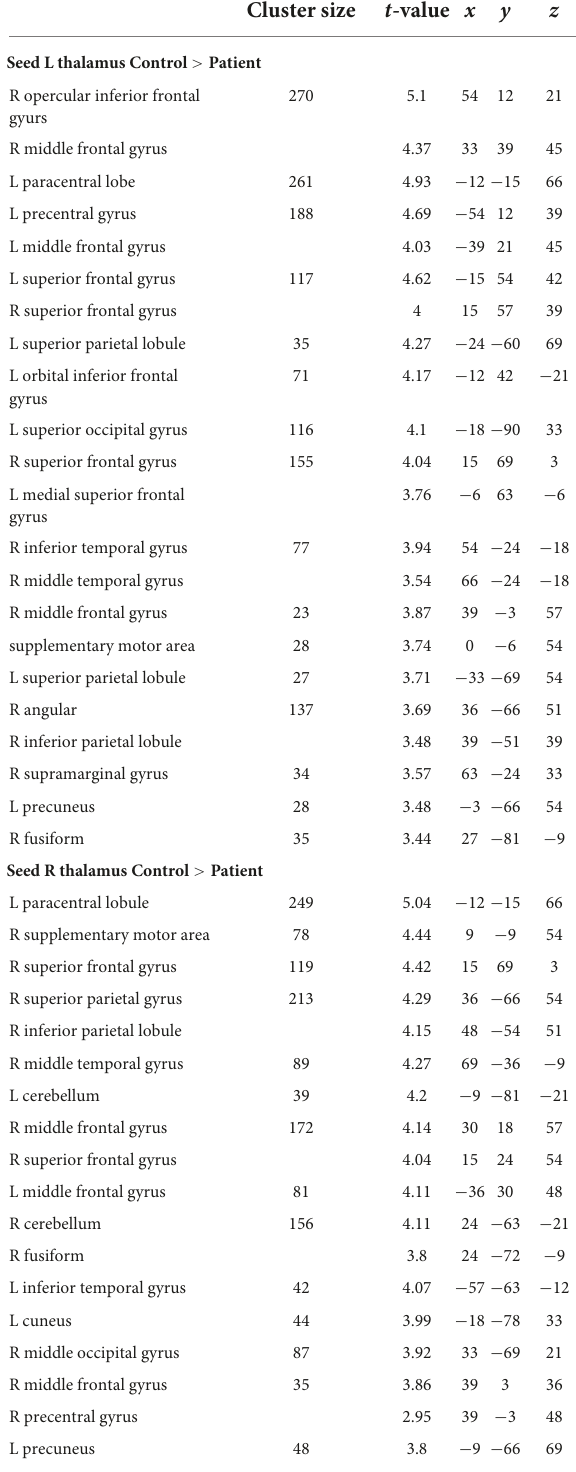
TABLE 3 Significant group differences in dFC